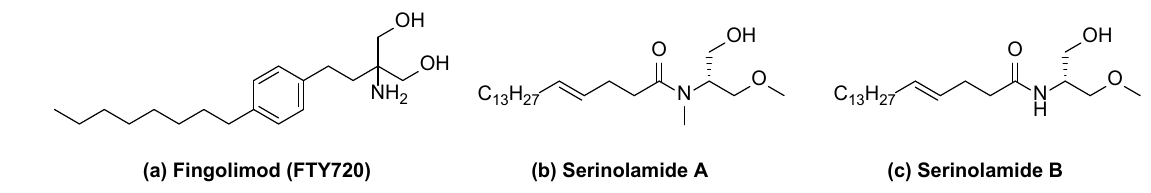
Figure 1. Structures of fingolimod ( a ), serinolamide A ( b ), and serinolamide B ( c ).